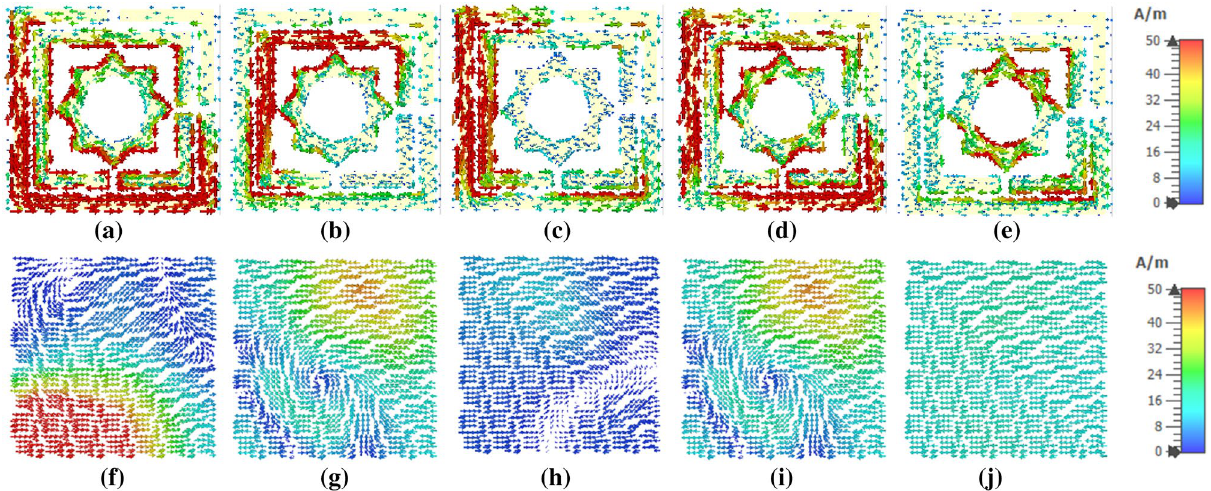
Figure 10. Sufrace current distribution of the MAA unit cell: front view ( a )–( e ); back view ( f )–( j ) at the resonance frequencies 3.80, 5.65, 8.45, 10.82 and 15.92